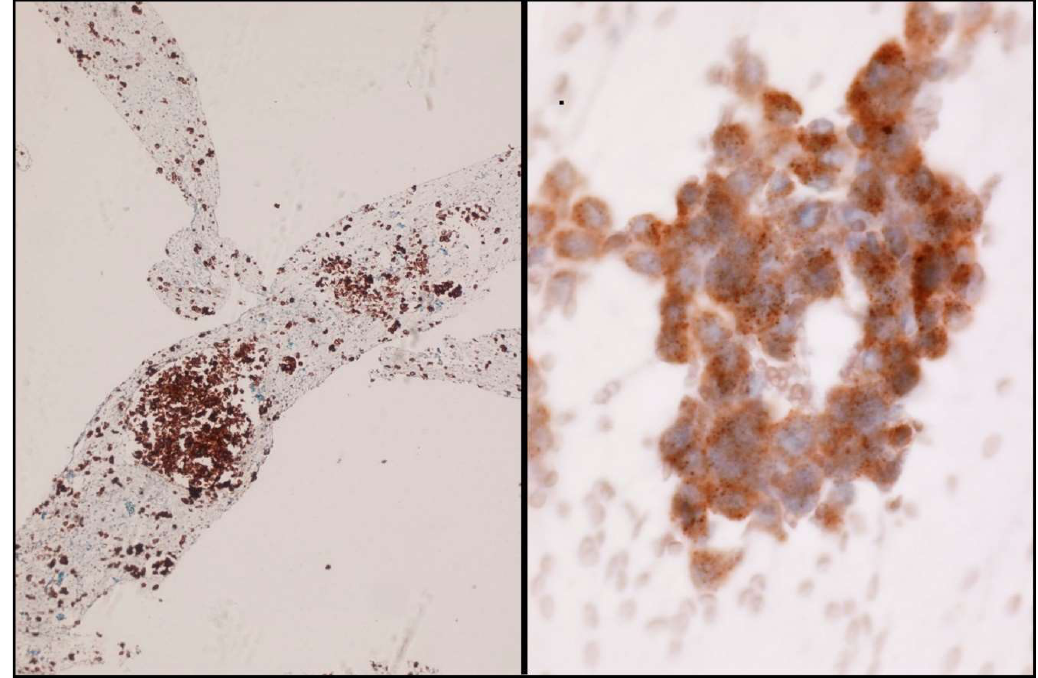
Figure 4. Some examples of ALK immunostaining. Cell-block ( Left ) and smear ( Right ).